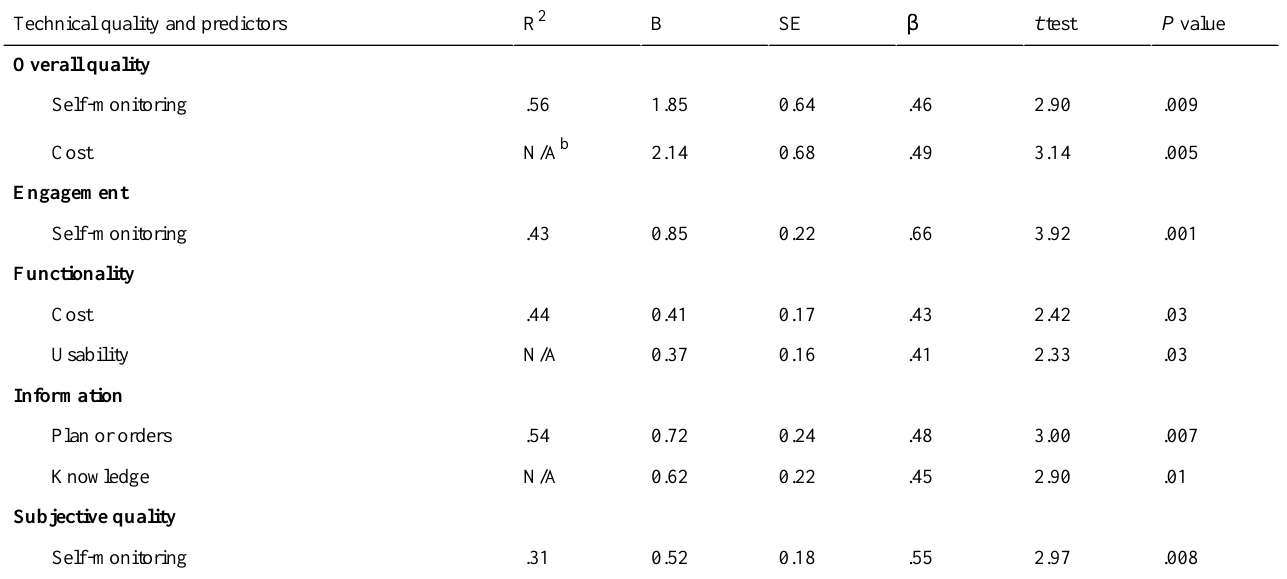
Table 3. Predictors of technical quality in evaluated dialysis diet apps (N=22) a